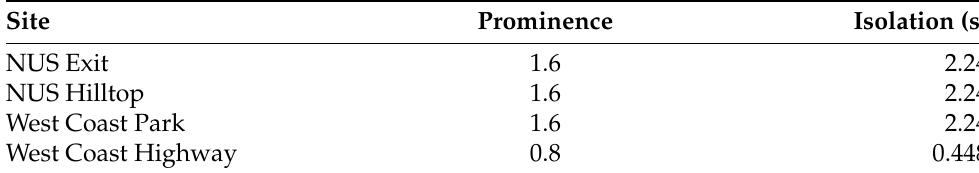
Figure 4. Illustration of the method for motor vehicle identification. Top : time domain high-frequency seismic recording. Bottom : spectrogram of the time domain signal. The red line is the total PSD summed over 30 Hz and 150 Hz. The large, isolated peaks are identified as motor vehicles. Table 1. Parameters for vehicle identification at three